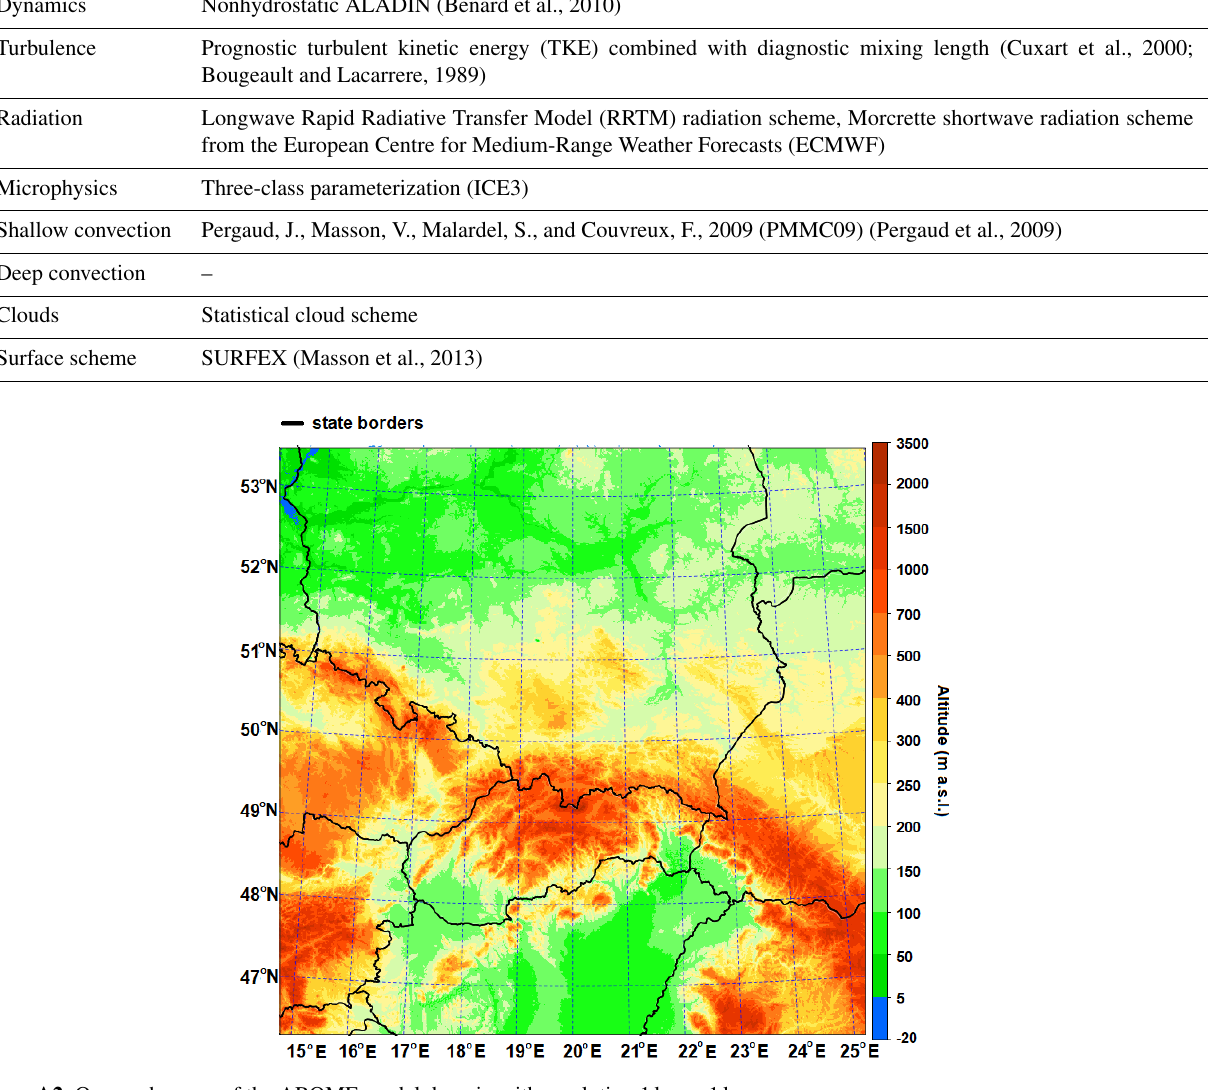
Figure A2. Orography map of the AROME model domain with resolution 1km × 1km. Table A3. Distribution of the temperature gradient between levels 200 and 50ma.g.l. depending on the wind speed at a height of 50ma.g.l. for the city centre in two cold seasons 2018–2020 obtained from the AROME model